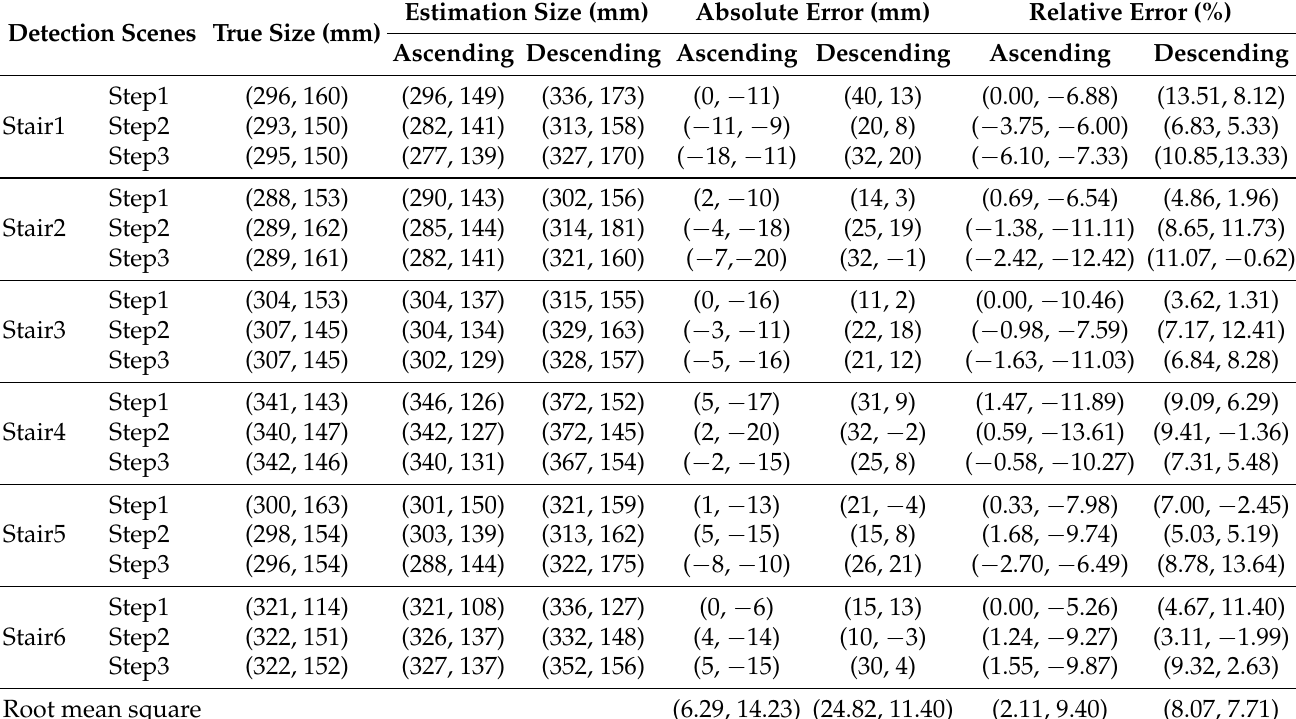
Table 8. Results of the stair geometric parameter estimation experiments. A cell is denoted as (width,